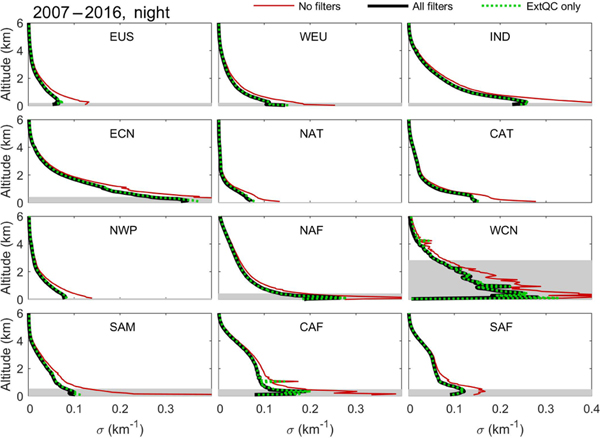
Regional σ¯ with no filters (red), all filters (black), and the extinction QC filter only (green dashed) for 2007–2016 at night, all-sky. The median surface elevation indicated by the shaded grey region.